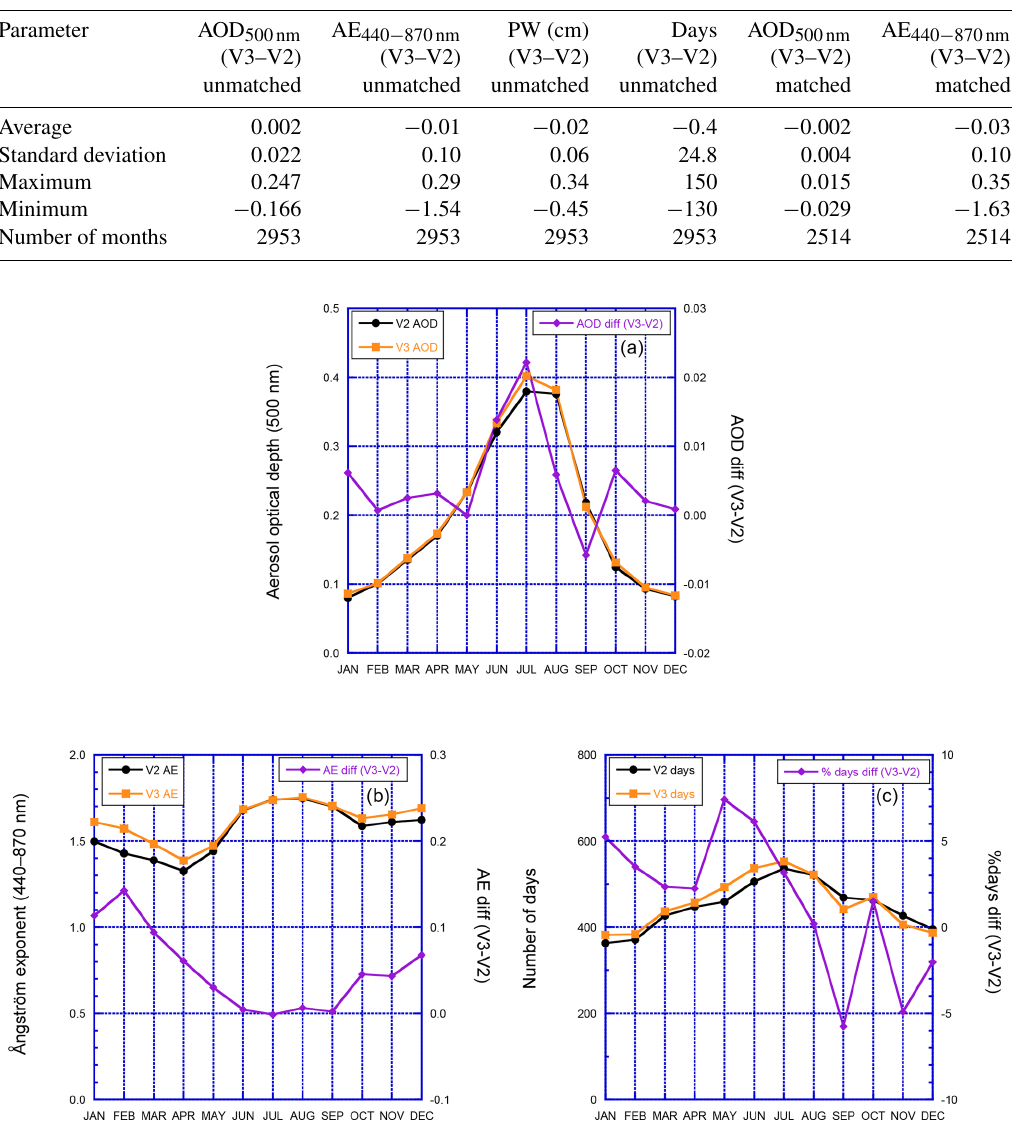
Figure 23. Long-term multiyear (1993–2016) monthly average comparisons of the Version 3 and Version 2 Level 2.0 data sets at the NASA Goddard Space Flight Center (GSFC), Maryland, USA. Panel (a) provides the AOD interpolated to 500nm for each version on the primary y axis and differences on the secondary y axis. Panels (b) and (c) are plotted similarly for the AE 440 − 870nm and the number of days in the multiyear monthly average,